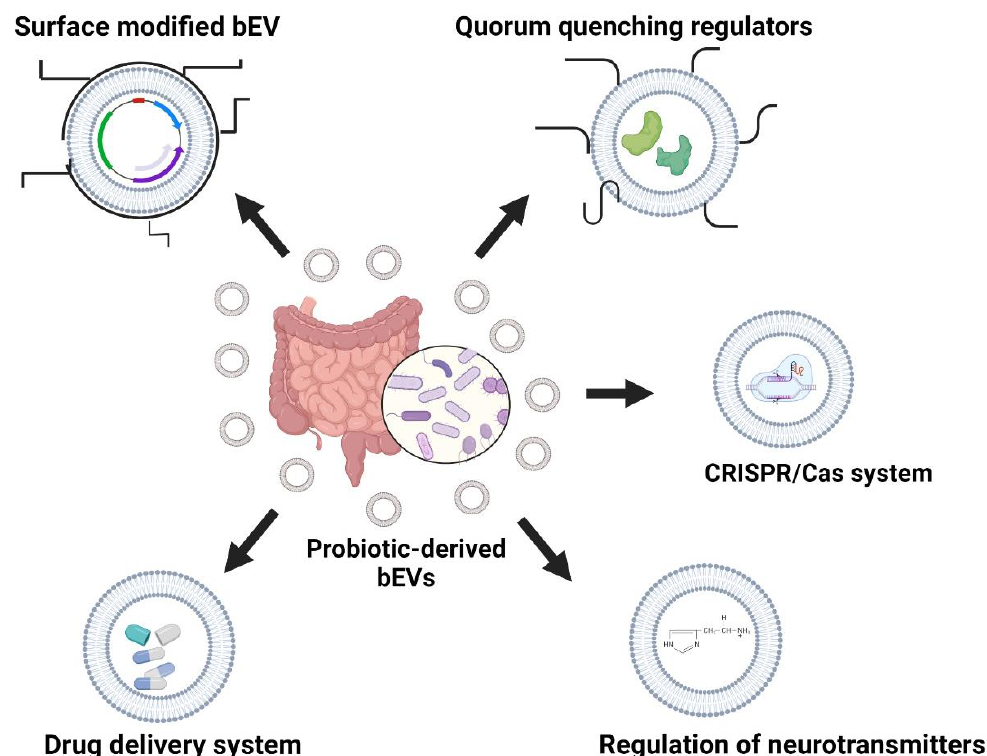
Figure 3. Remodeling of probiotic-derived bEVs against BBB related anomalies. The figure was cre- ated using BioRender.com (https://app.biorender.com; accessed on 3 November 2022). created using BioRender.com (https://app.biorender.com; accessed on 2 November